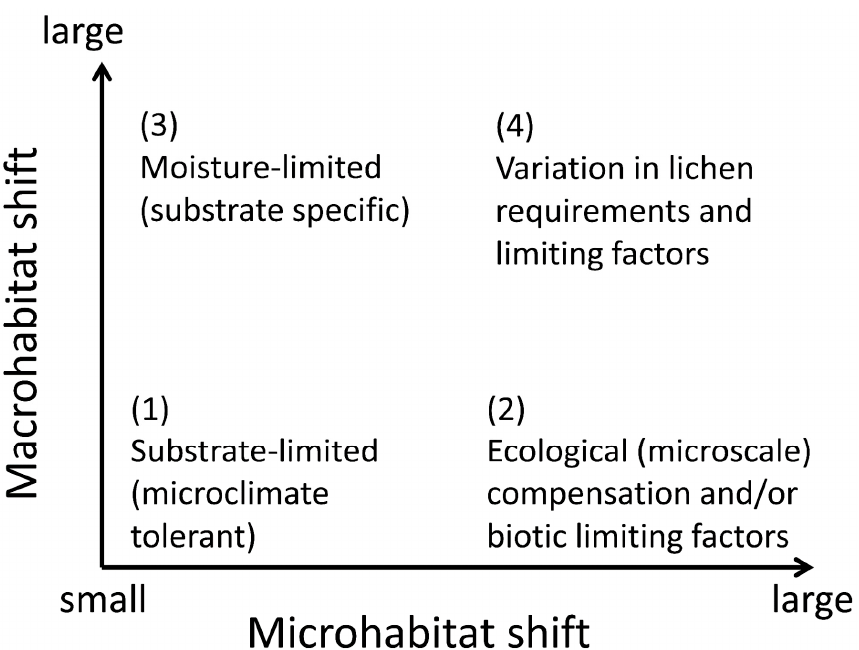
Figure 3. A framework of habitat-use responses to ecophysiological challenges posed by large distribution ranges in lichens. The responses include shifting microhabitats within a macrohabitat, consistent microhabitat use across varying macrohabitats, and shifts at both scales or none at all.